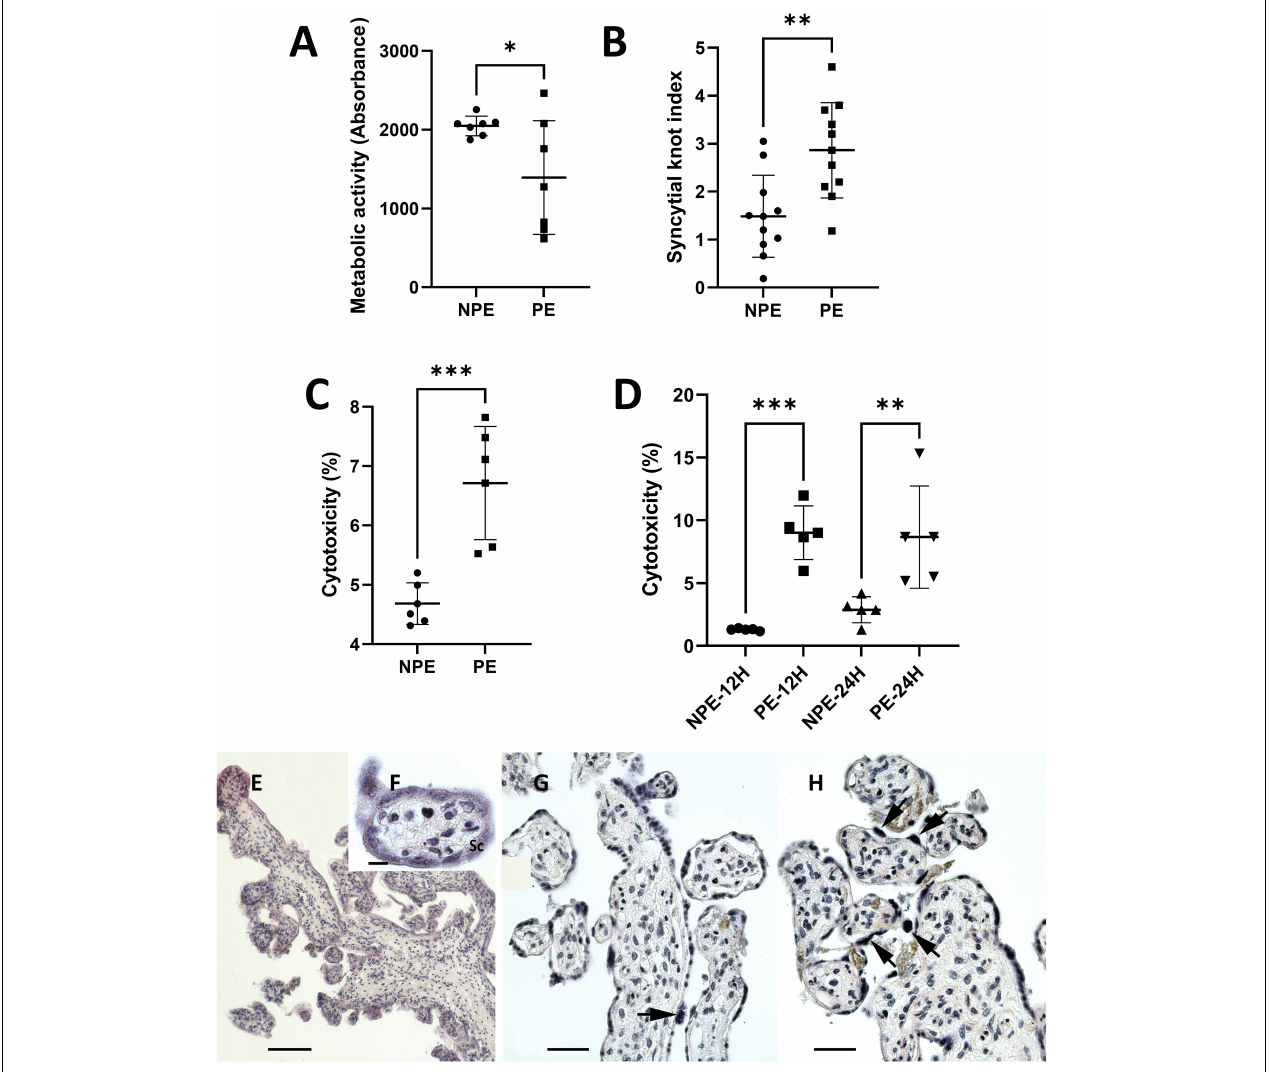
FIGURE 2 | Influence of PE serum on placental explants (A–C) and HTR8/SV-neo trophoblast cells (D) . (A) Mitochondrial metabolic activity of placental explants treated with PE serum for 24 h. Controls were prepared with serum from NPE pregnant women. Placental PE-treated samples showed lower viability than control ( n = 7). (B) Syncytial knots index in PE-serum treated and control placental explants ( n = 11). (C,D) LDH levels released by placental explants (C) , 24 h, n ( 6) and HTR8 cells (D) 12 and 24 h, n ( 5) after treatment with PE serum. LDH release was higher in PE serum-treated cultures than in controls. Data were analyzed using the unpaired Student’s t -test followed by the Mann-Whitney posttest. The values are represented as mean ± SD. The experiments were repeated at least three times on different occasions. ∗ p < 0.01; ∗ p < 0.05, ∗∗∗ p < 0.005. (E–H) H.E.-stained sections of 24 h-cultured explants with NPE serum (E–G) and PE serum (H) . The morphology of the explants appears to be relatively normal (E–G) . Syncytial knots (arrows) were more evident in PE-serum treated explants (H) . Scale bars represent 200 µ m in (E) 20 µ m in (F) , and 100 µ m in (G,H)